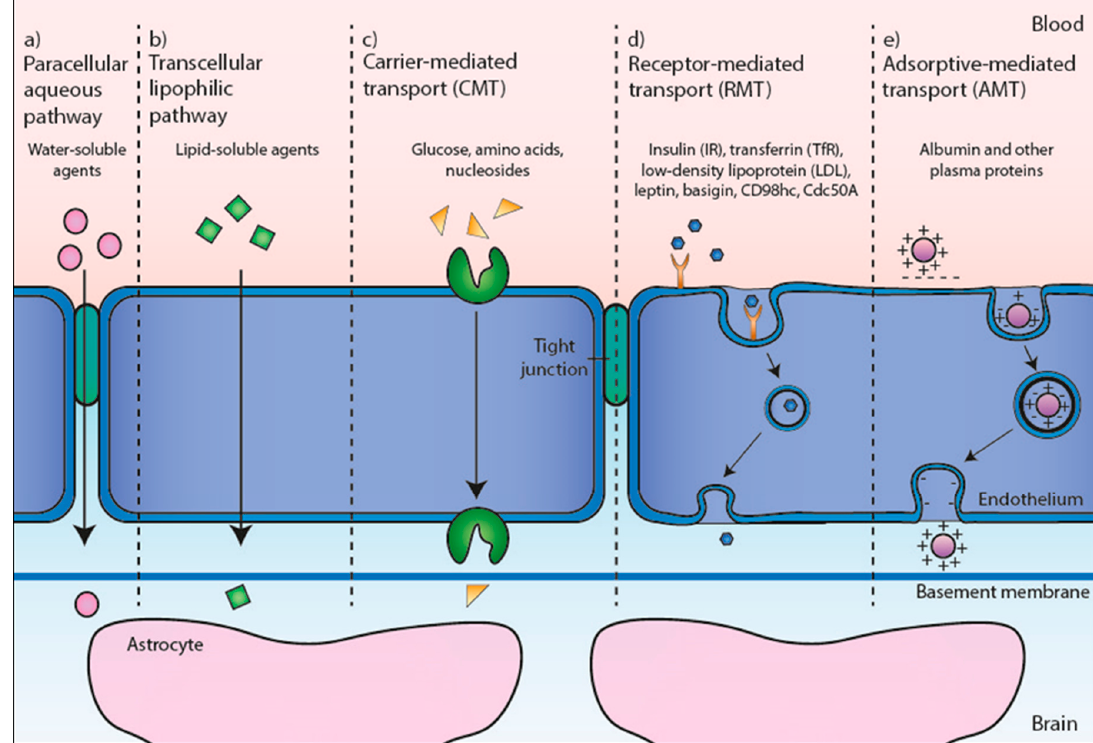
Figure 2. Pathways across the blood–brain barrier (BBB). Representation of the BBB formed by the endothelial cells and their interaction with astrocytes. Different translocation routes are presented. ( a ) Tight junctions usually restrict the penetration of water-soluble compounds. ( b ) The large surface area of the lipid membranes of the endothelium offers an efficient diffuse route for lipid-soluble agents. ( c ) Several transport proteins (carriers) are present in the endothelium for glucose (Gluc-1), amino acids, nucleosides, and other substances. ( d ) Large molecules such as antibodies, lipoproteins, proteins, and peptides can only transverse the BBB by receptor-mediated transport (RMT). ( e ) The transport of native plasma proteins or peptides is limited, but cationization can increase their uptake by adsorptive-mediated transport (AMT).